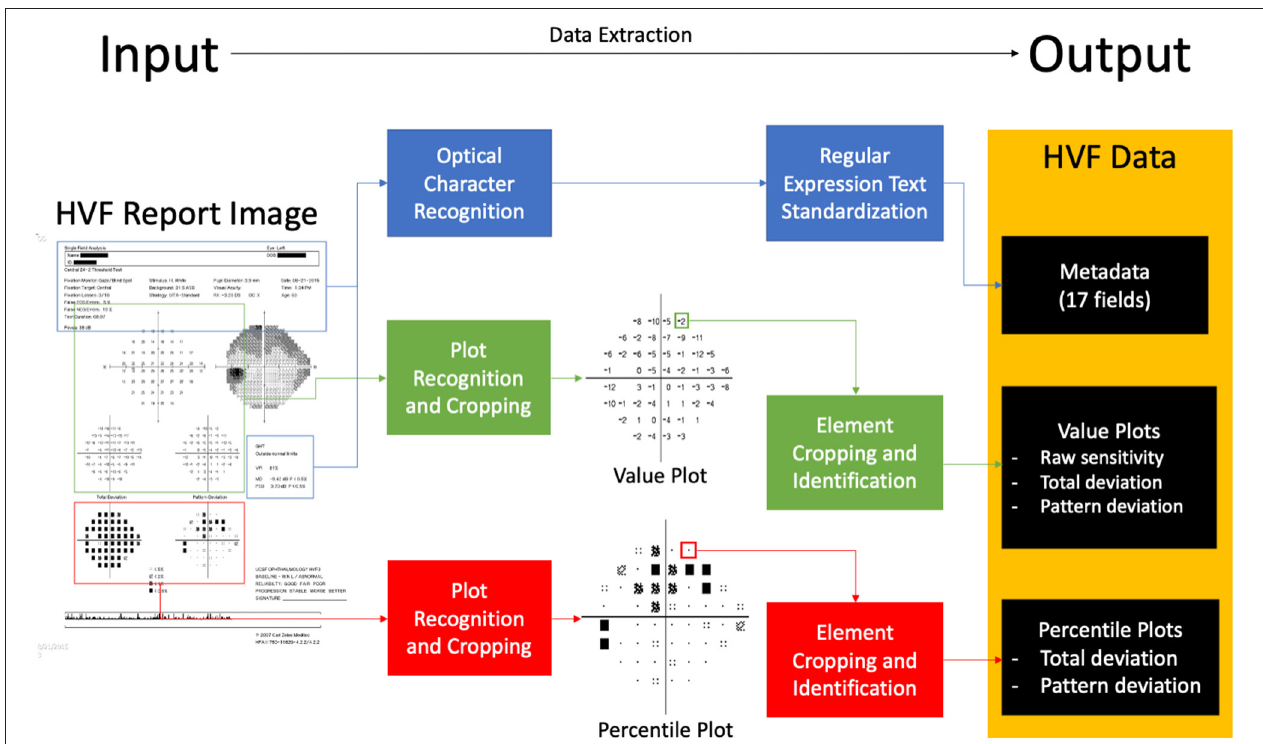
FIGURE 1 | Block diagram of extraction software. An input visual field report identifies areas of metadata, value plots and percentile plots, processes and extracts data, and outputs structured data.